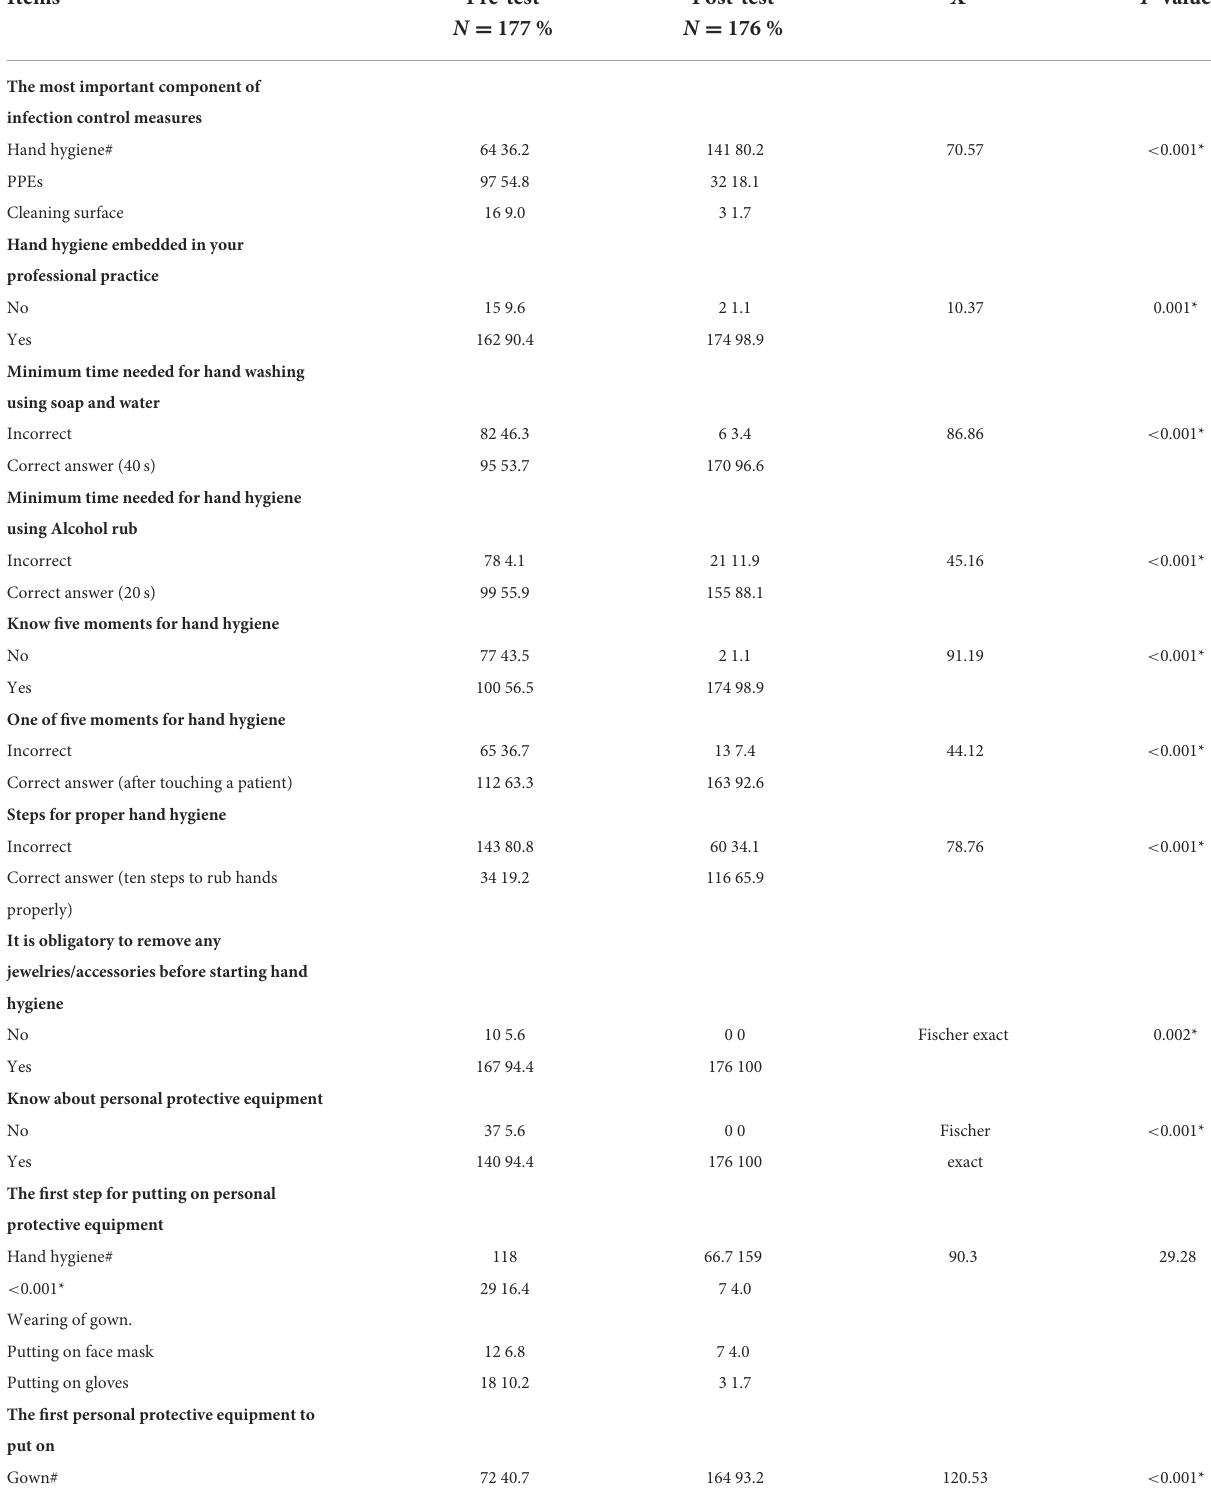
TABLE 2 Comparison between students’ knowledge about infection control measures before and after